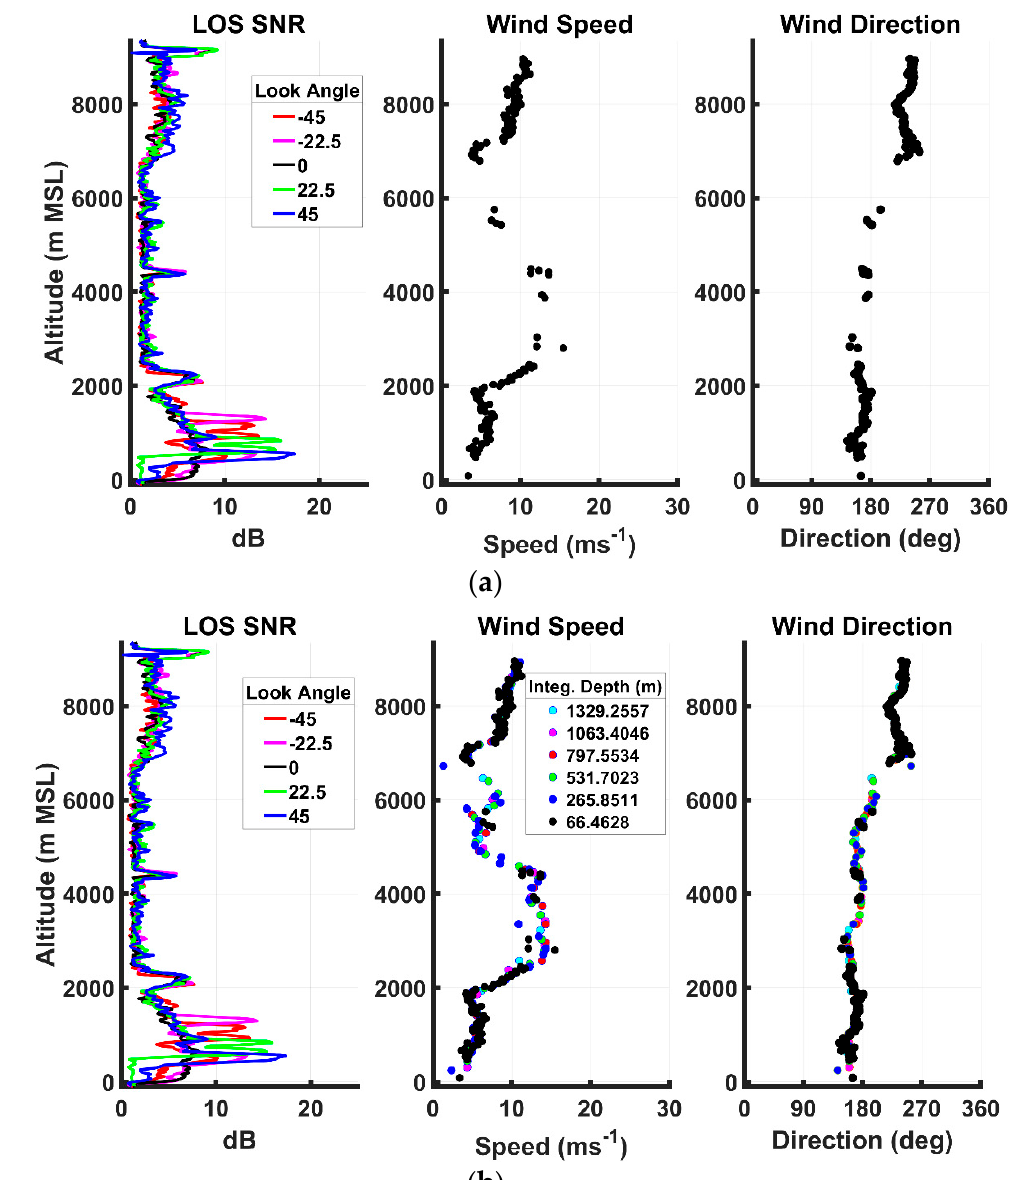
Figure 4. DAWN base vertical profiles of SNR, wind speed and wind direction processed with a single range gate ( a ) and adaptive integration over 5 integration depths ( b ) for a weak low-level wind case on 11 June 2017 181034Z.